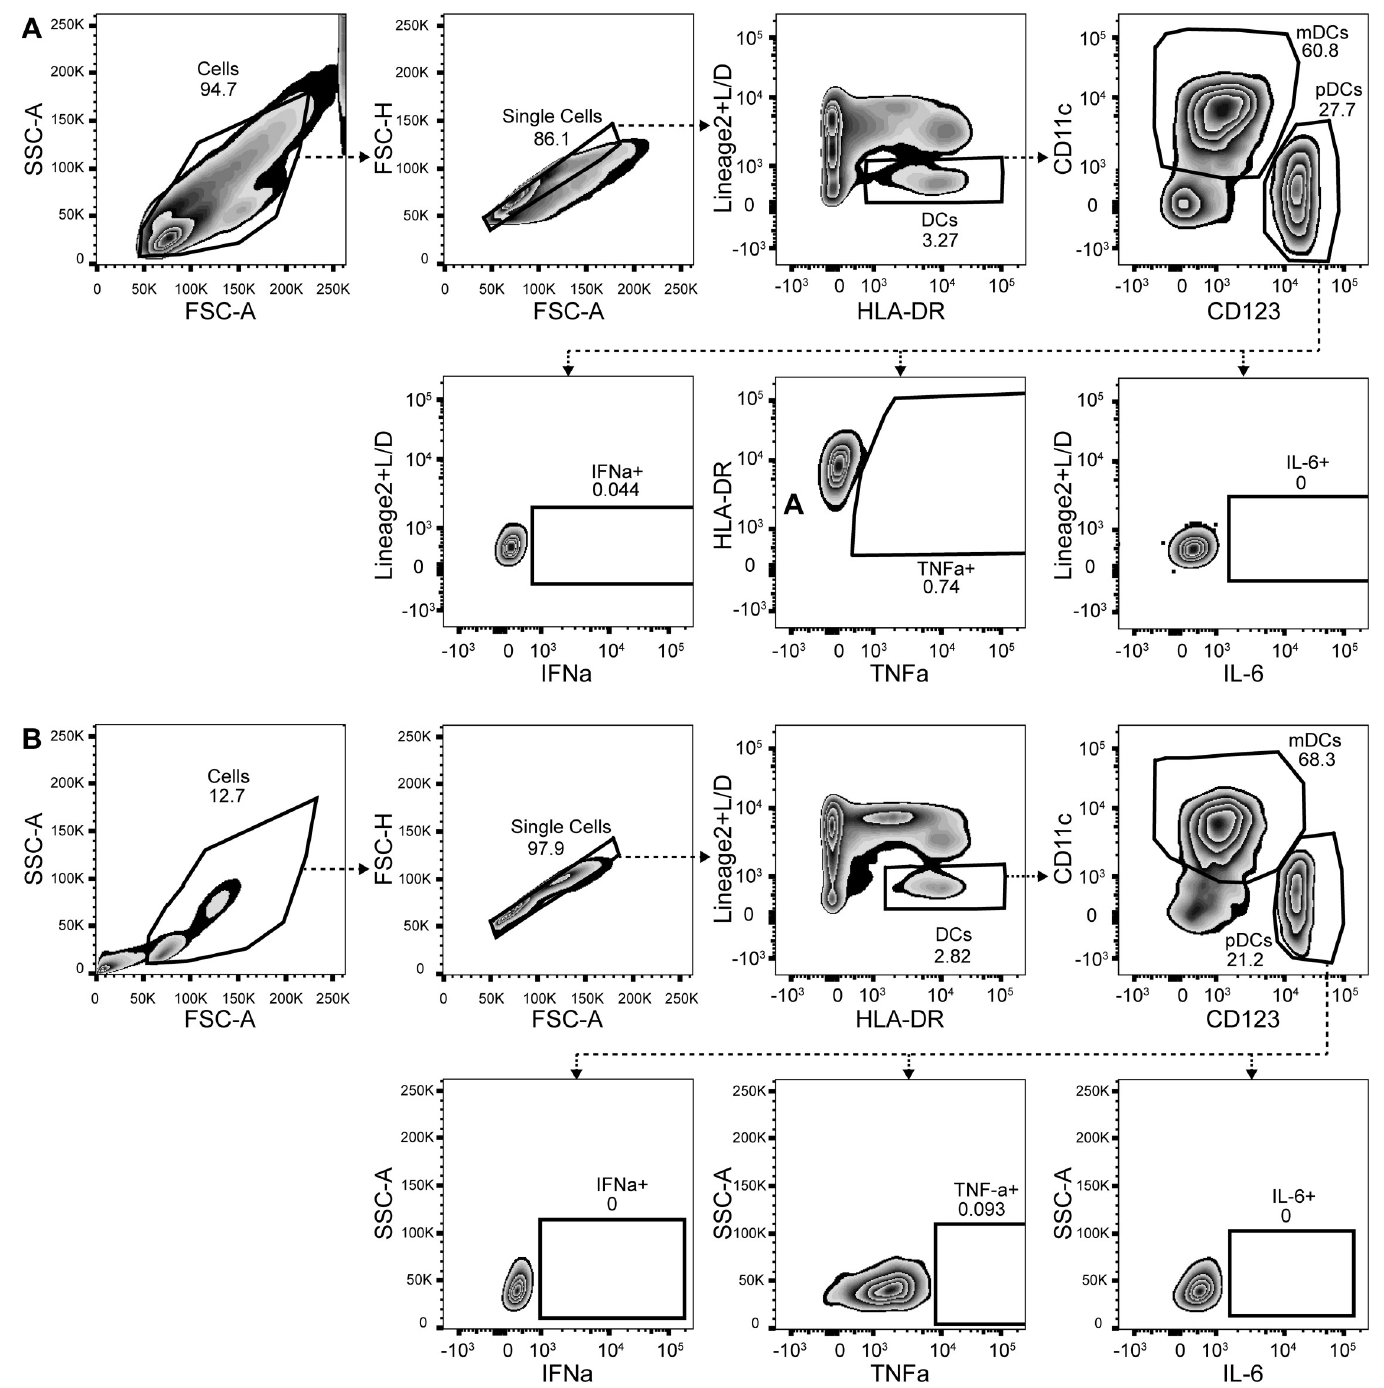
Fig 1. Gating strategy of intracellular cytokine production by a donor from the elderly population (171/002) (A) or a donor from the young adult population (171/ young/003) (B) in steady state (RPMI).